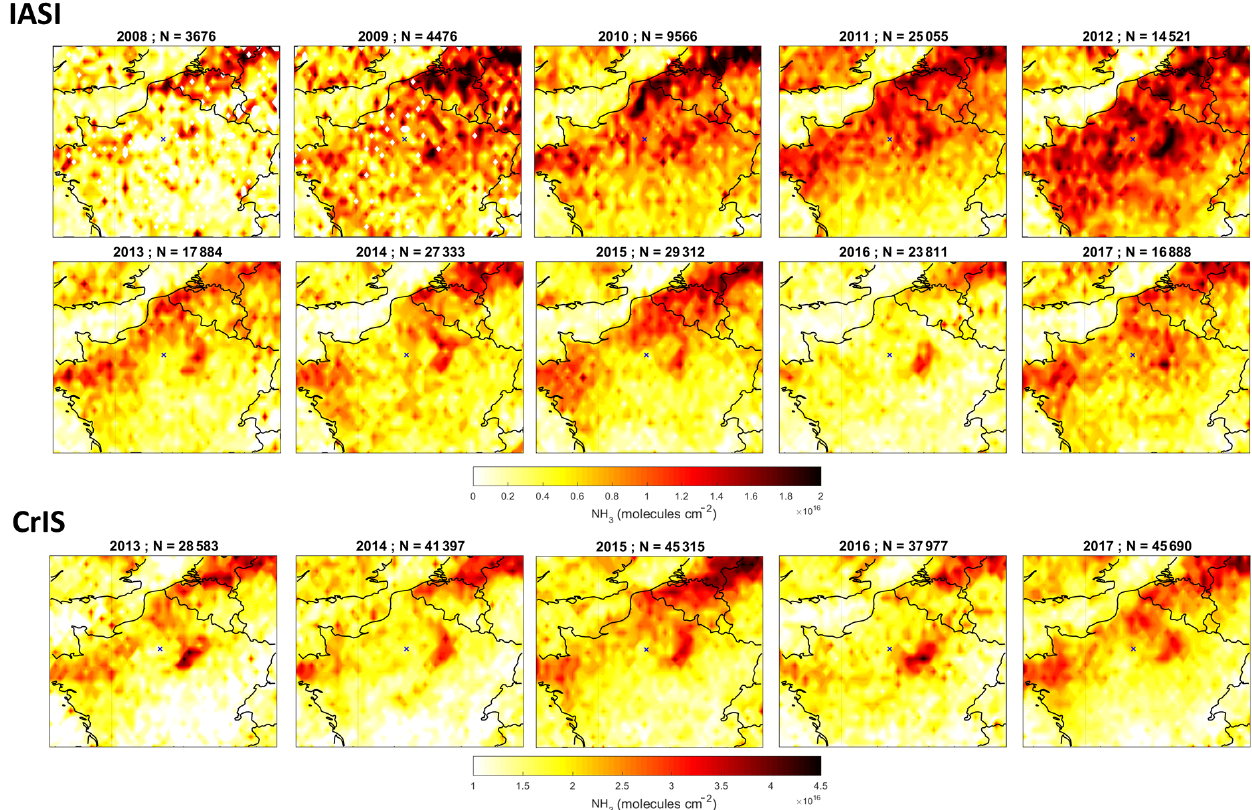
Figure 4. Maps of monthly mean NH 3 total columns (moleculescm − 2 ) in the March–April period derived from IASI observations from 2008 to 2017 and CrIS observations from 2013 to 2017.